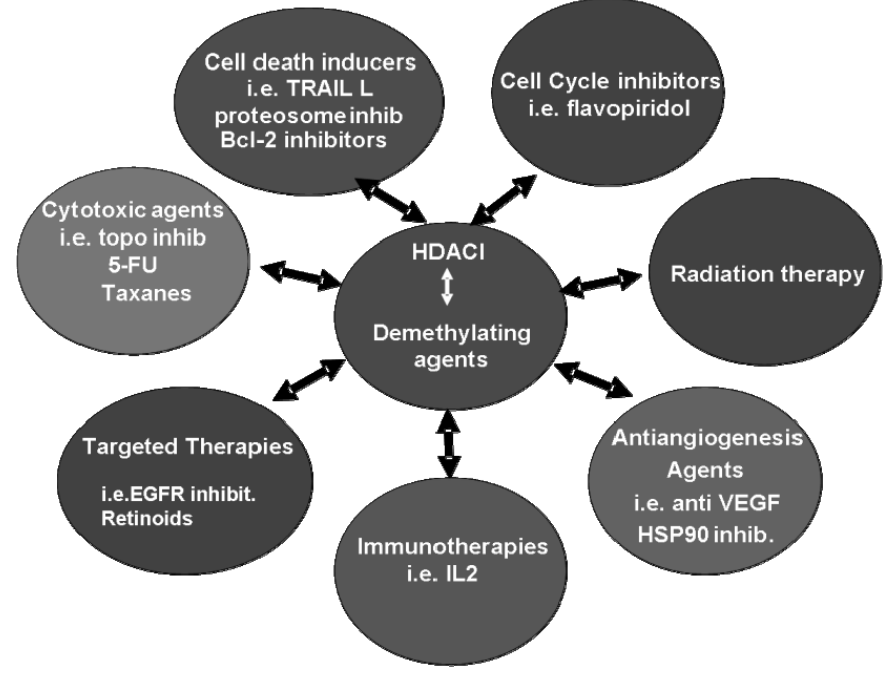
Figure 1. Schematic cartoon representing pre-clinical and clinical combination strategies with